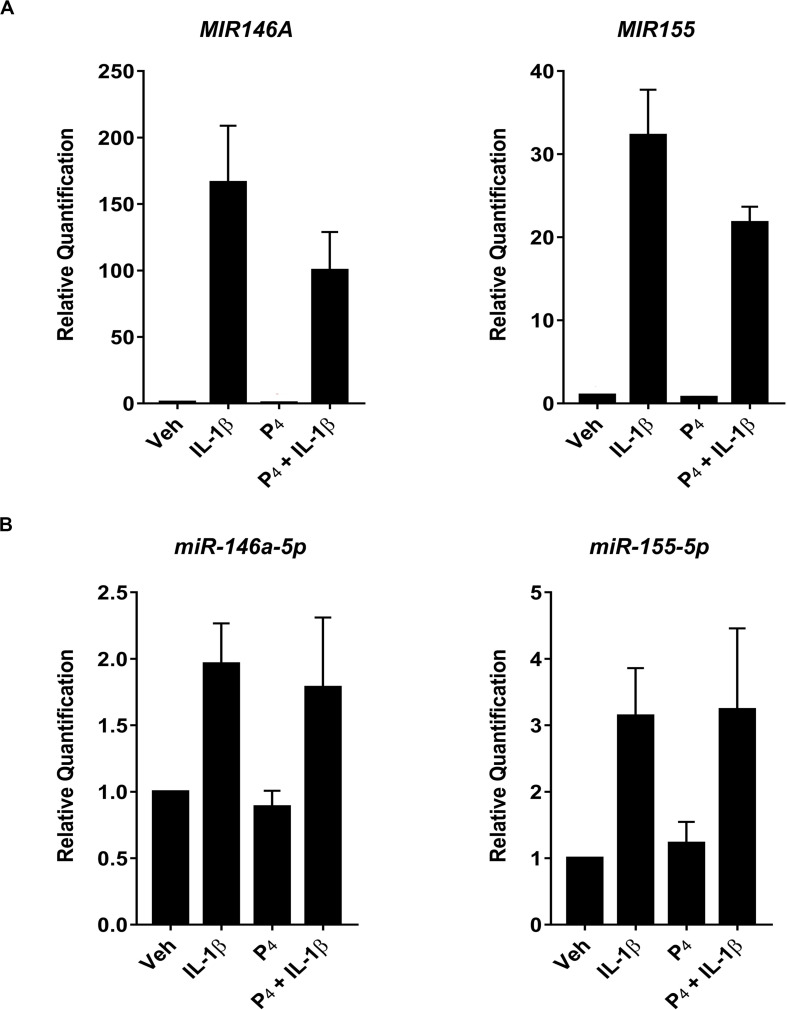
Quantitative RT-PCR measurement of select primary/precursor and mature miRNA transcripts in cervical stromal fibroblasts from vehicle-, IL-1β-, P4, or IL-1β + P4-treated cells. Three separate experiments (carried out in duplicate) using biological replicates were incubated with the test agents listed above for 4 h, and then total RNA was isolated, quantified and subjected to RT-PCR using primers specific for either the primary/precursor or mature miRNA transcripts. (A) Primary/precursor miRNA transcripts. (B) Fully processed, mature miRNAs. Data are expressed as mean ± SEM of relative intensity (target/human acidic ribosomal protein) and were analyzed by one-way ANOVA followed by Tukey’s test for differences (p < 0.05, considered significant).